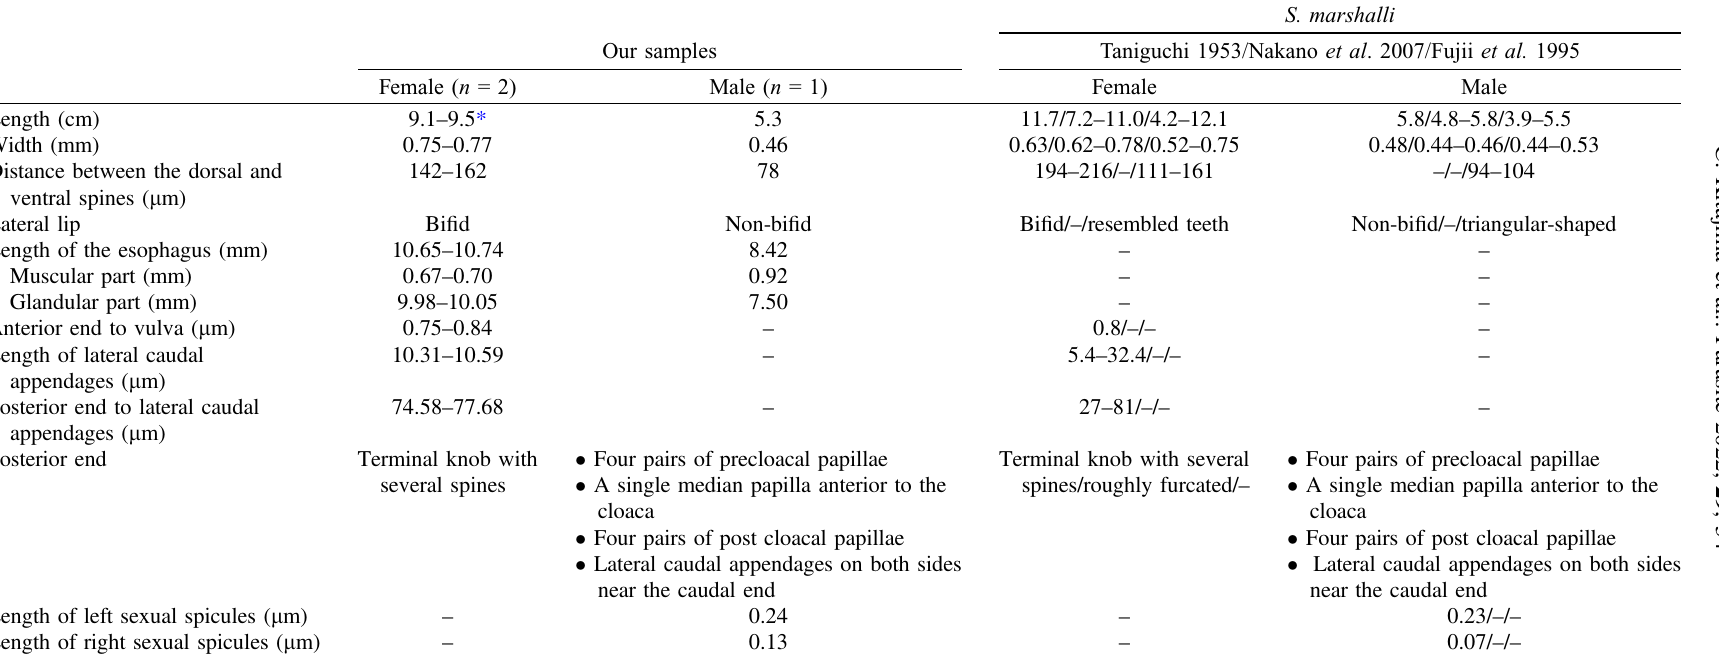
Table 1. Morphological characteristics of Setaria